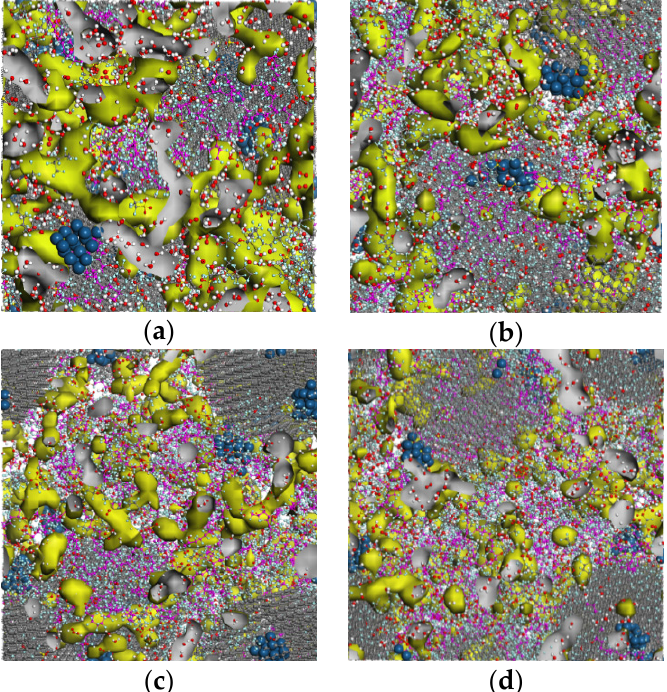
Figure 10. Water distribution and cluster form in CL at different ionomer-to-carbon ratios: ( a ) I/C = 0.4; ( b ) I/C = 0.8; ( c ) I/C = 1.2; and ( d ) I/C = 1.6.